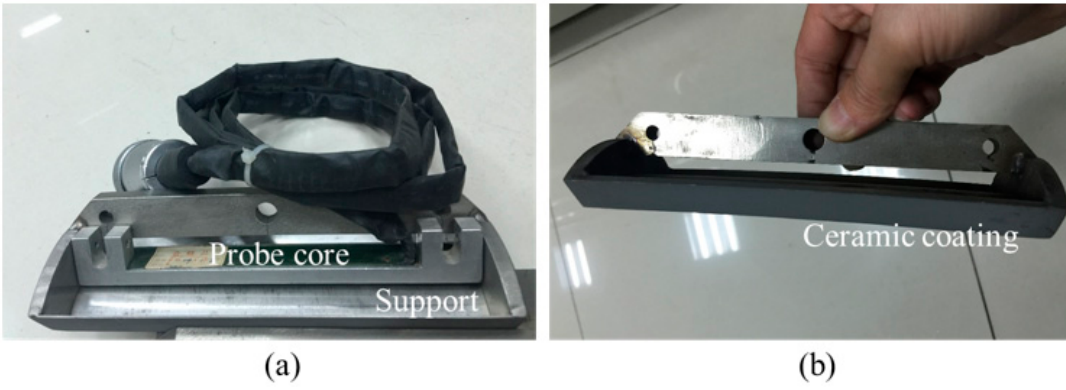
Figure 8. The online MFL probe for steel pipe (unit: mm).